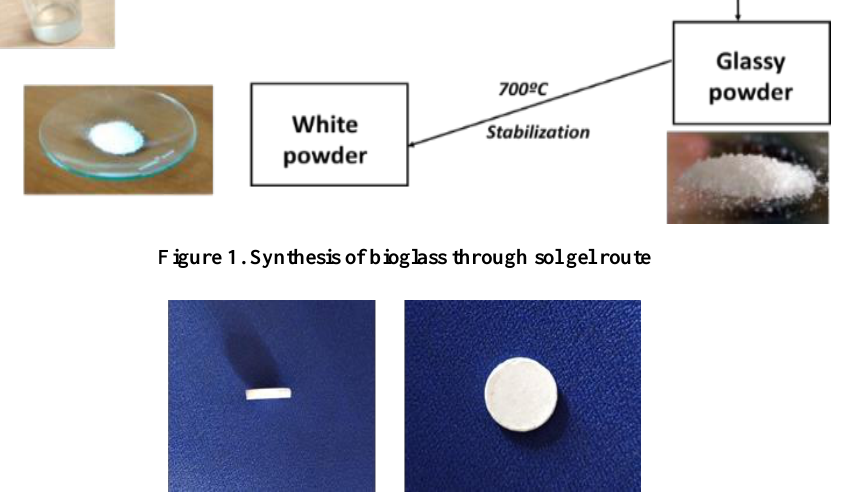
Figure 2. Dry pressed bioglass